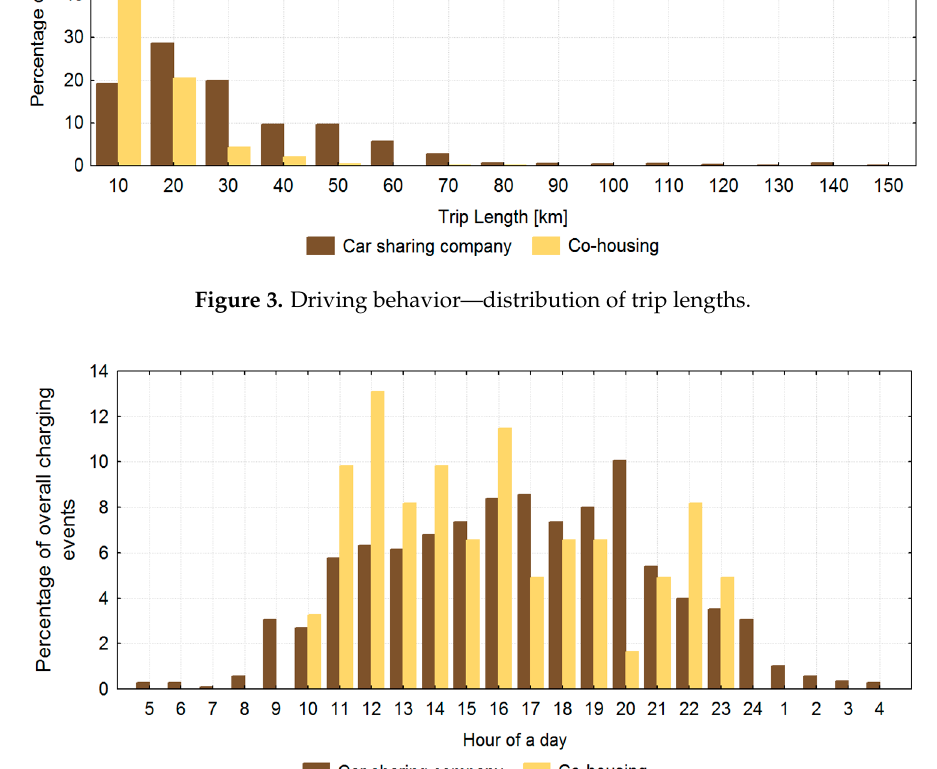
Figure 4. Charging behavior—an hour of a day when the charging event started.